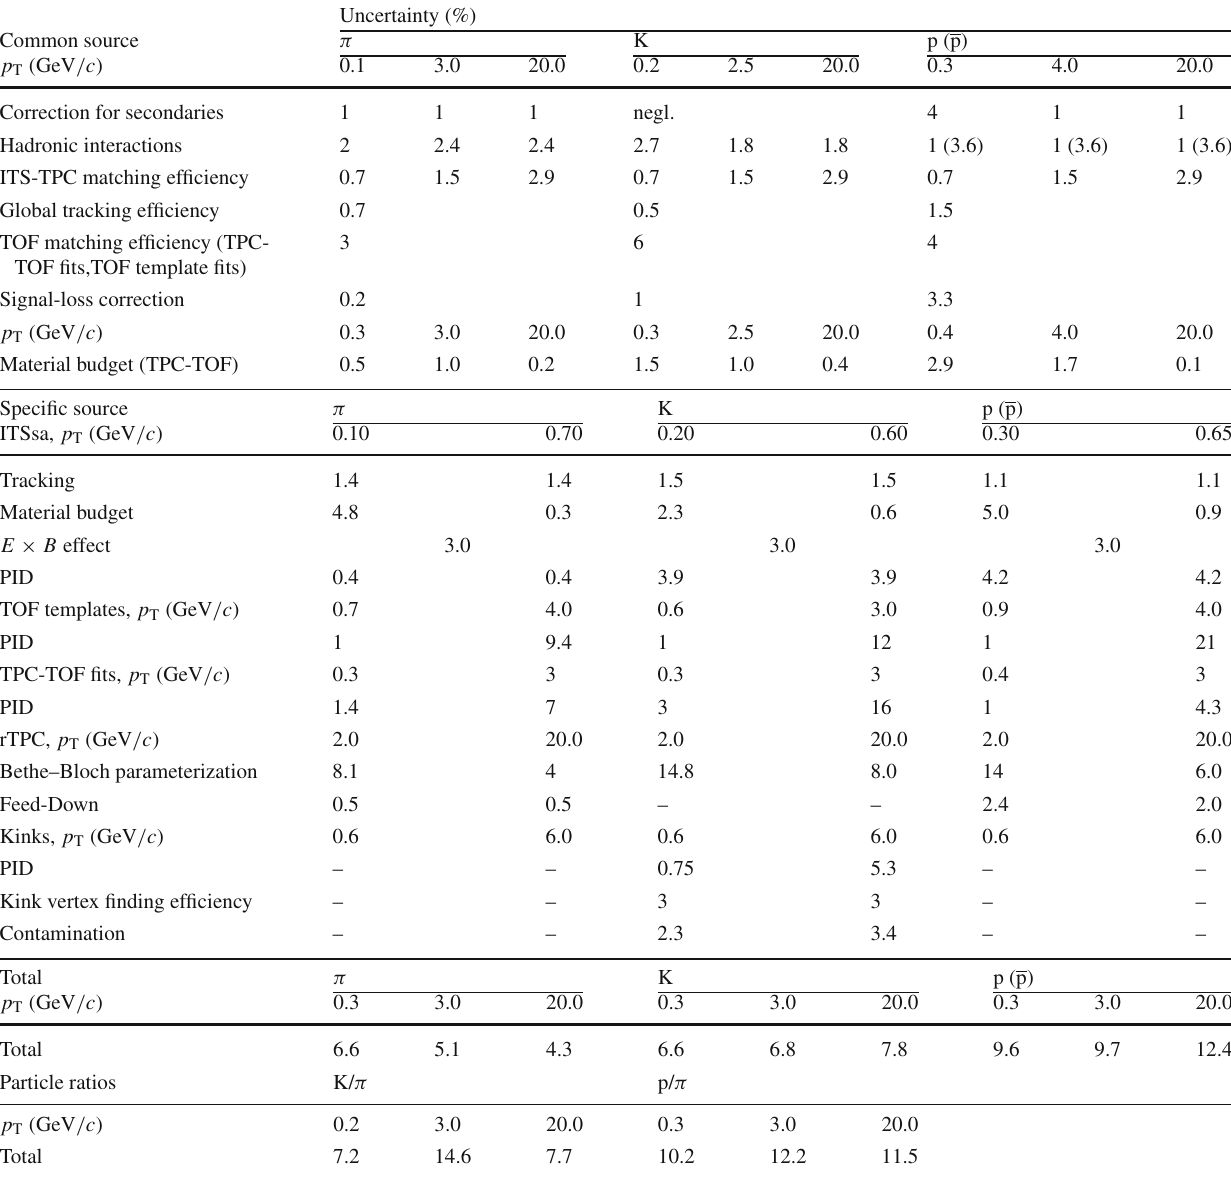
intermediate and high p T . Numbers in parenthesis in the p column refer to p uncertainties. In the last rows, the maximum (among multiplicity classes) total systematic uncertainty is